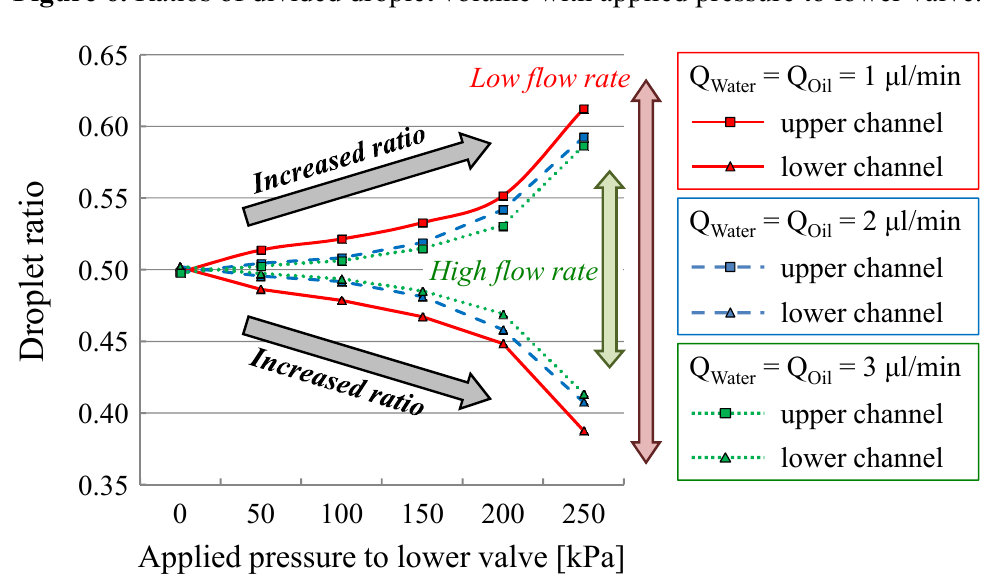
Figure 6. Ratios of divided droplet volume with applied pressure to lower valve.